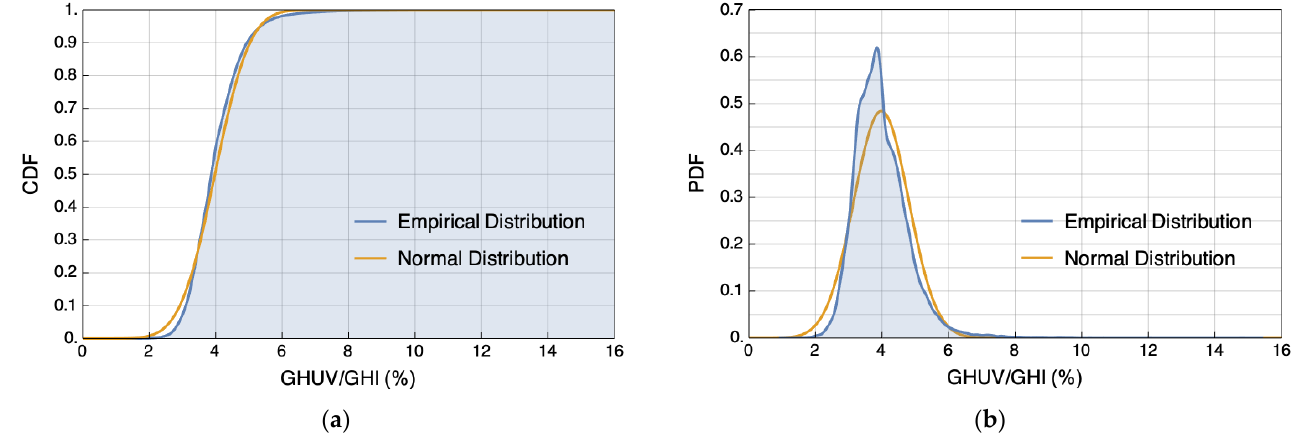
Figure 5. Cumulative distribution function ( a ) and probability distribution function ( b ) of the 10 min data measured during the experimental campaign. Both the empirical CDF and PDF (blue line), and the CDF and PDF that were adjusted to a normal distribution function (yellow line), are plotted.